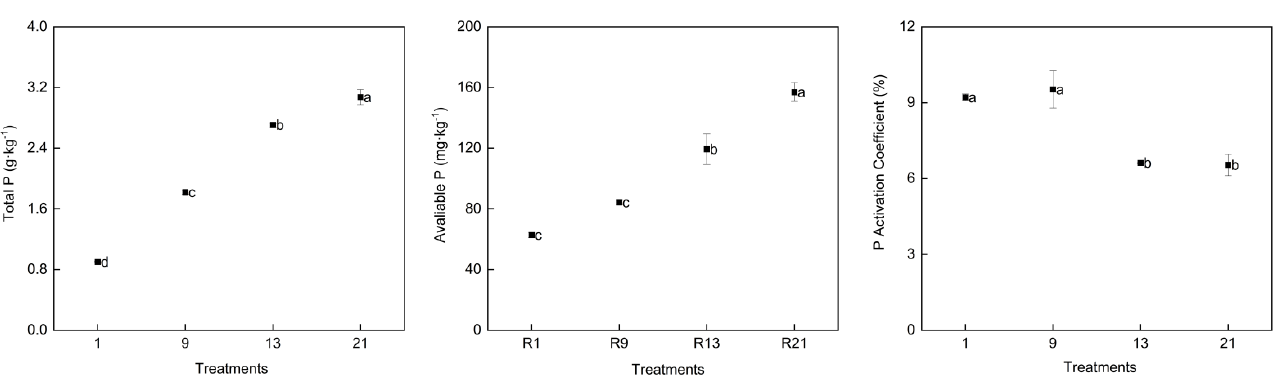
Table 4. Effects of continuous cropping on P uptake and distribution of cucumbers in the solar greenhouse.